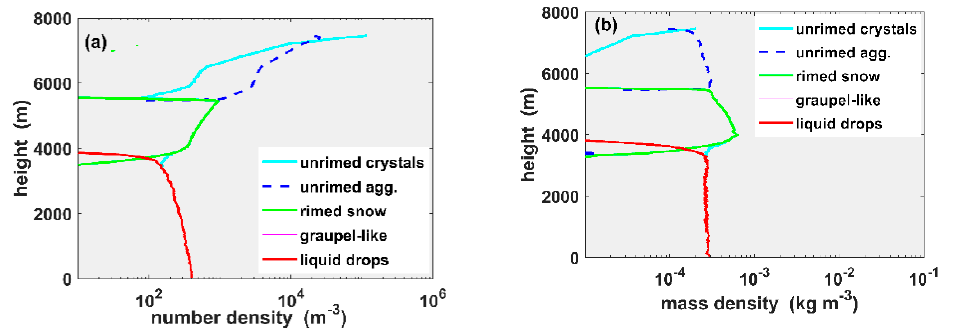
Figure 4. ( a ) Vertical profile of number density for control run; ( b ) as in (a) except for mass density.